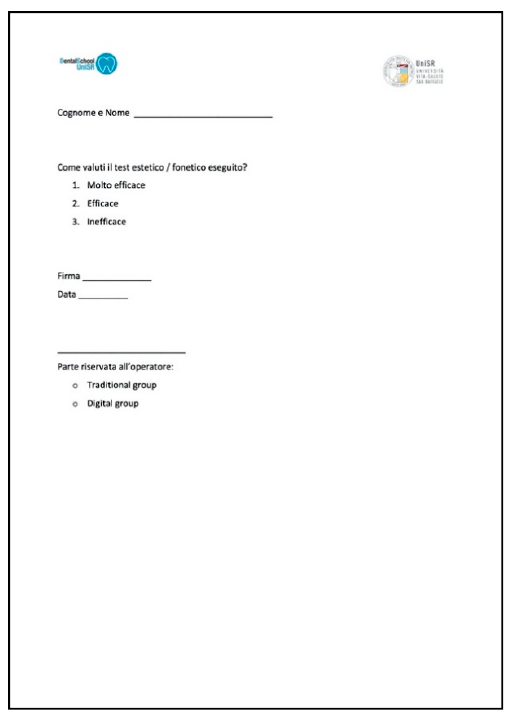
Figure A1. Questionnaire 1.